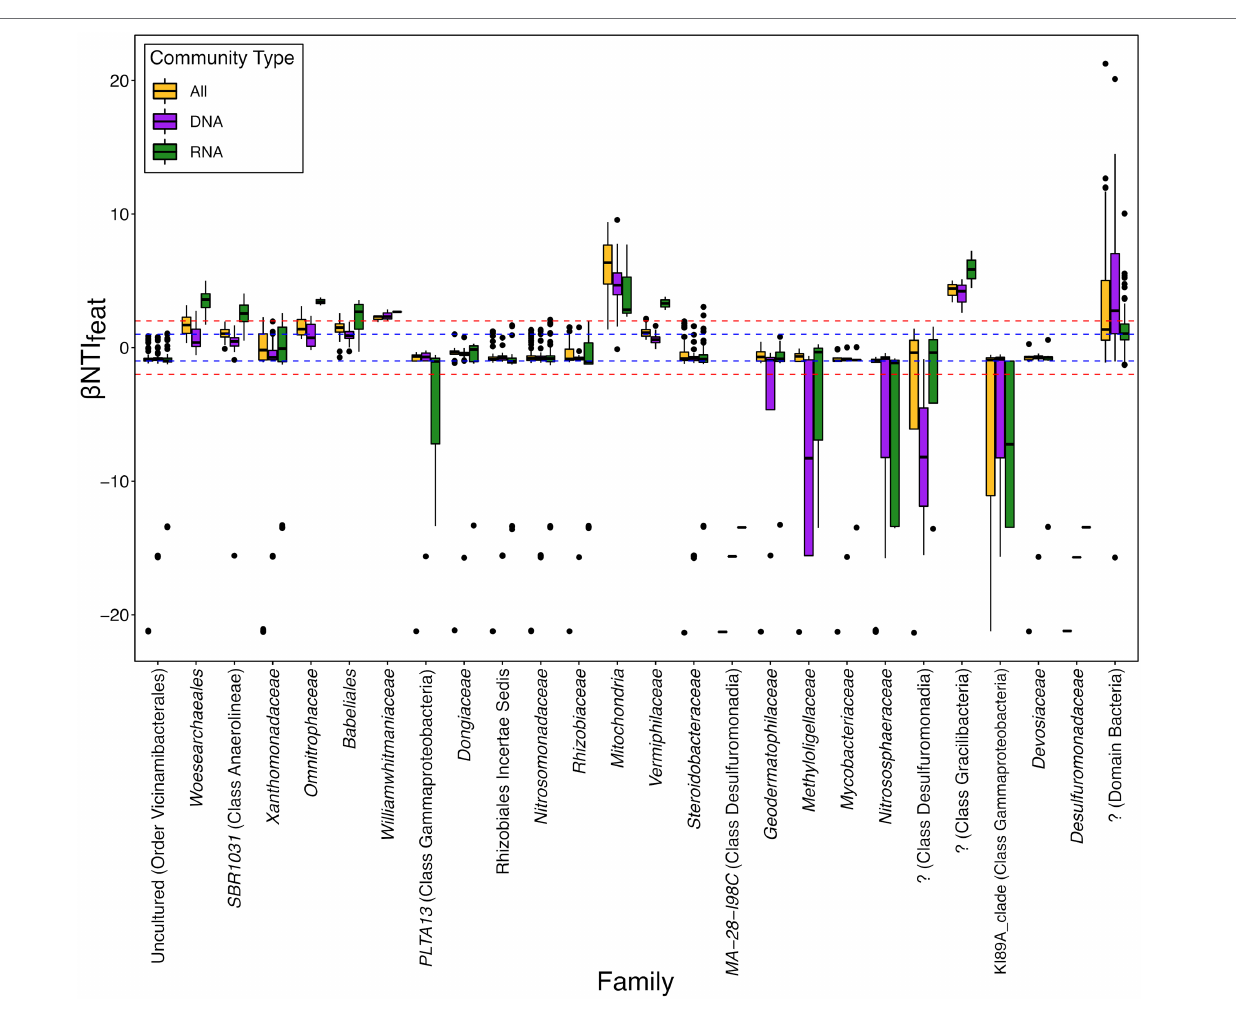
( Figure 3 ; Supplementary Figure 1 ). For example, an unknown family from Class Desulfuromonadia significantly drives convergence ( β NTI feat < − 2) in the total community (DNA) but not in either the overall dataset (All) or putatively active (RNA) communities ( Figure 3 ). Conversely, the Family Woesearchaeales significantly drives ecological divergence ( β NTI feat > 2) within the putatively active community as compared to the total community or overall dataset. In the case of these example taxonomic groups, we hypothesize that this is likely tied to their respective inferred functional potentials. Class Desulfuromonadia tend to feature sulfate reducing bacteria, while described members of Family Woesearchaeles are fermentative (Castelle et al., 2015; Waite et al., 2020). Given that the experimental design allowed these sediments to maintain oxic conditions, this would act as